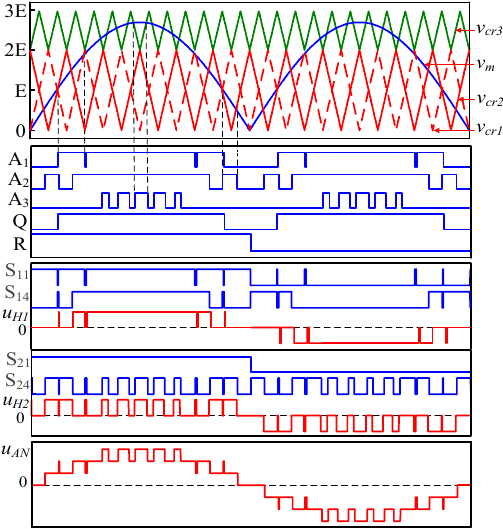
Figure 8. Schematic diagram of double frequency modulation based on LS-PWM.